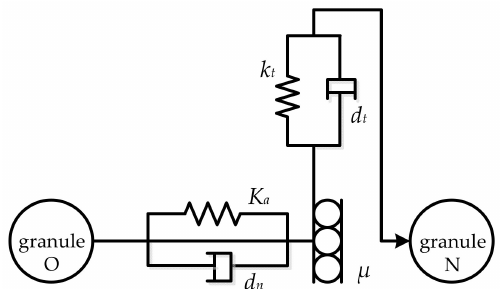
Figure 9. Model of contact